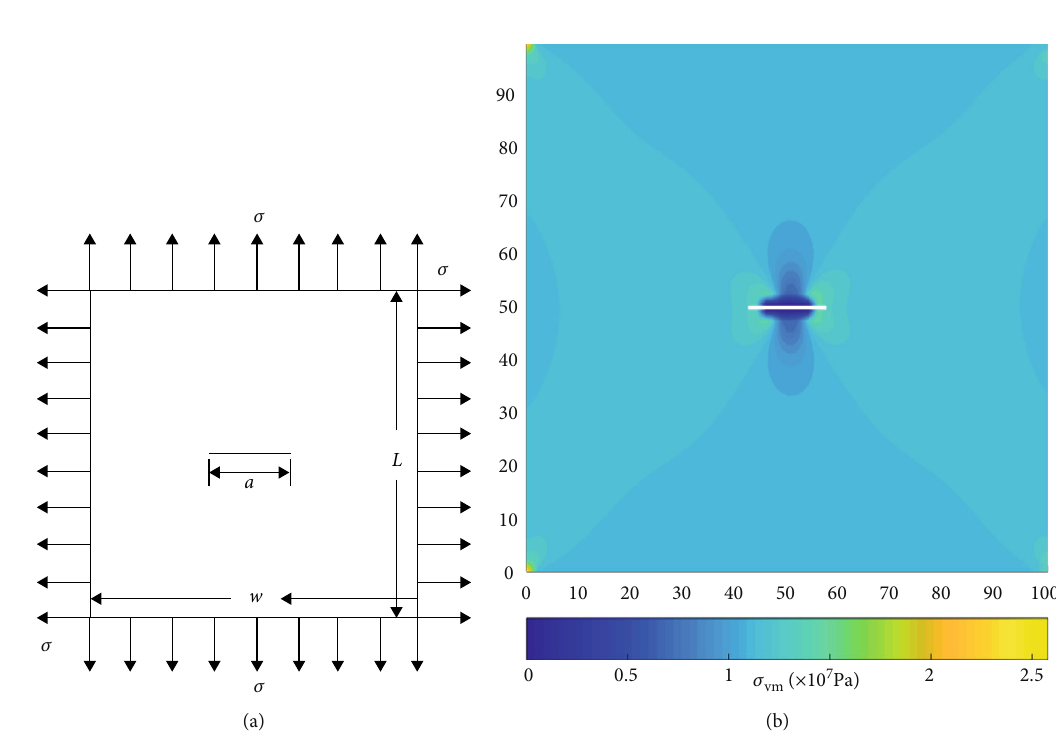
Figure 5: Central crack: (a) schematic of a w × L plate with an a -long horizontal central crack and loaded by normal tractions σ on all the edges; (b) shaded plot of the von Mises stresses σ vm for a 100 × 100 m 2 plate mesh and a = 15